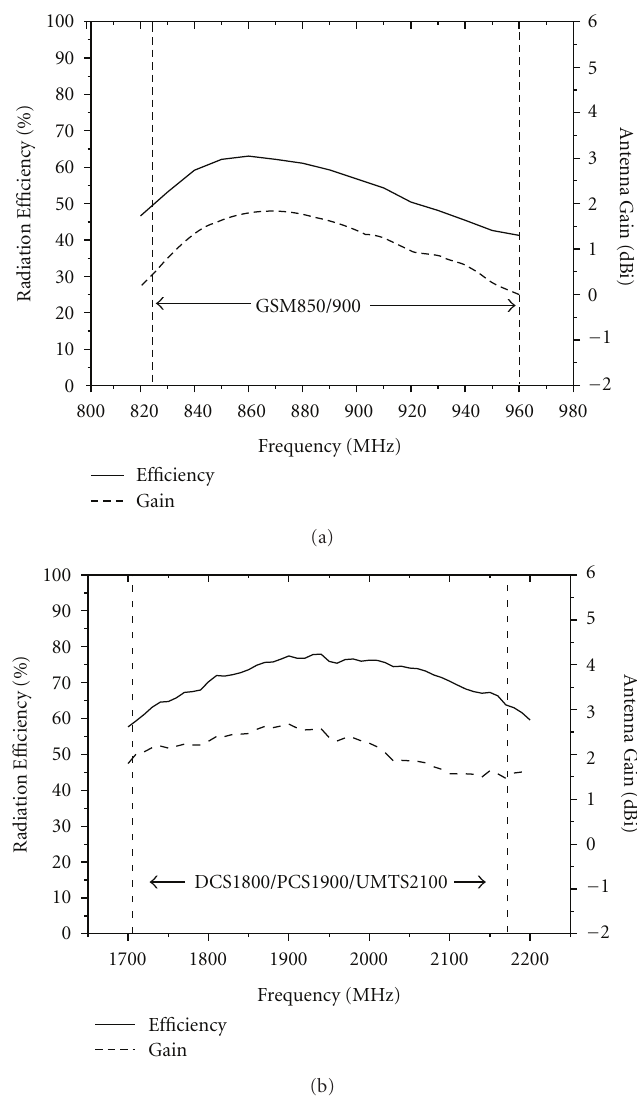
Figure 11: Measured antenna radiation e ffi ciency and antenna gain for the proposed antenna at (a) lower band and (b) upper